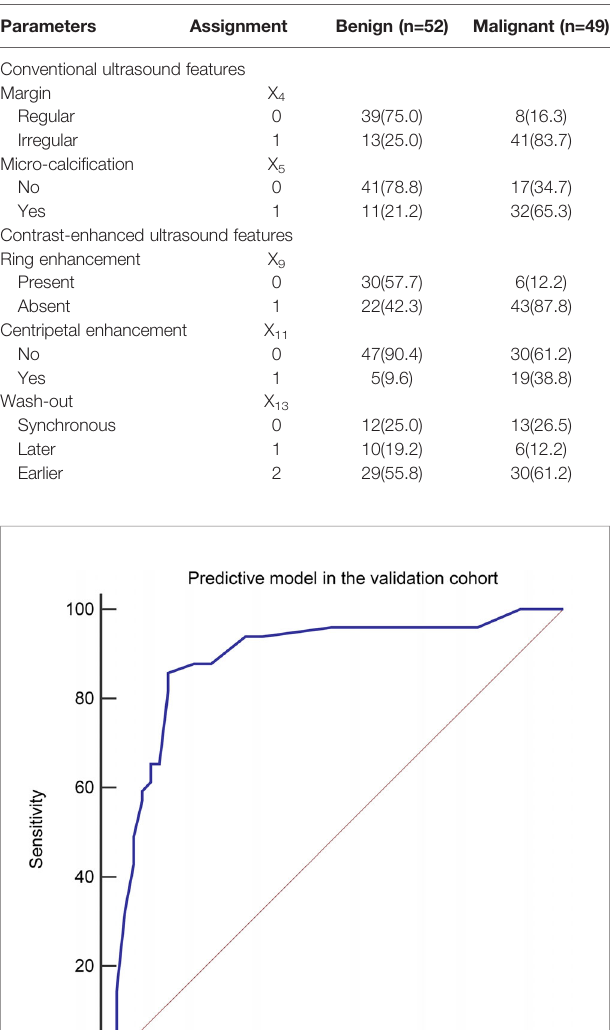
TABLE 7 | Features of risk factors of non-hypovascular thyroid nodules in the validation cohort.